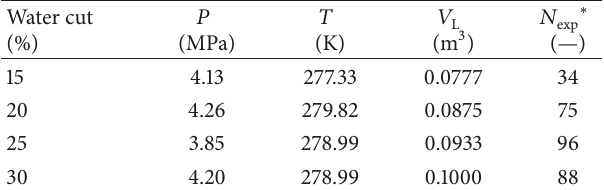
∗ 𝑁 exp : number of experimental data